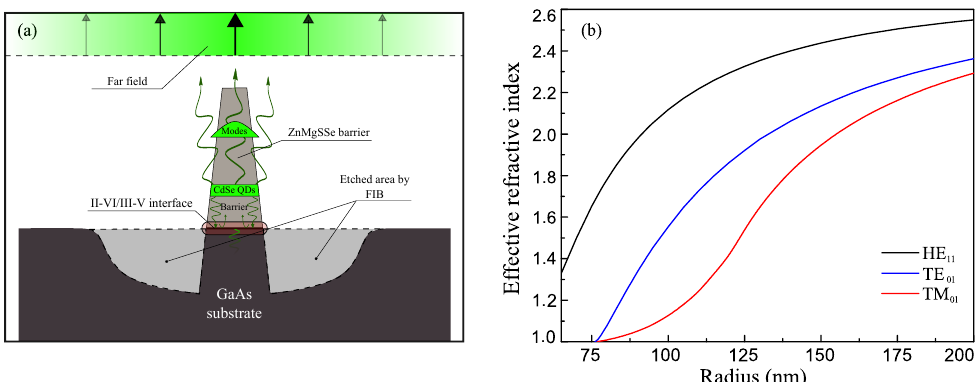
Figure 1. ( a ) Schematic of a photonic nanoantenna with inserted quantum dots (QDs). ( b ) Dispersion curves of 3 lowest modes in a cylindrical waveguide, calculated versus radius for a typical wavelength of 520